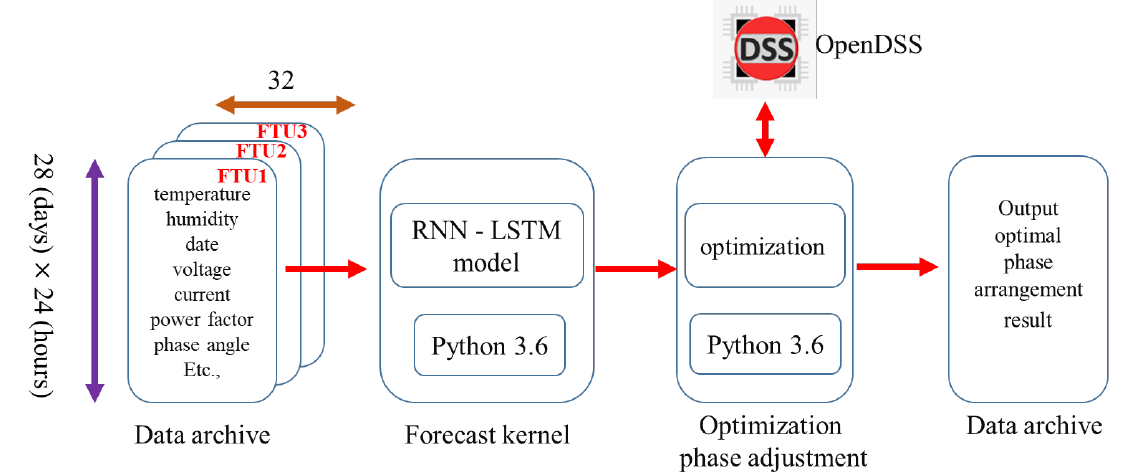
Figure 1. The solution procedure of the proposed approach.